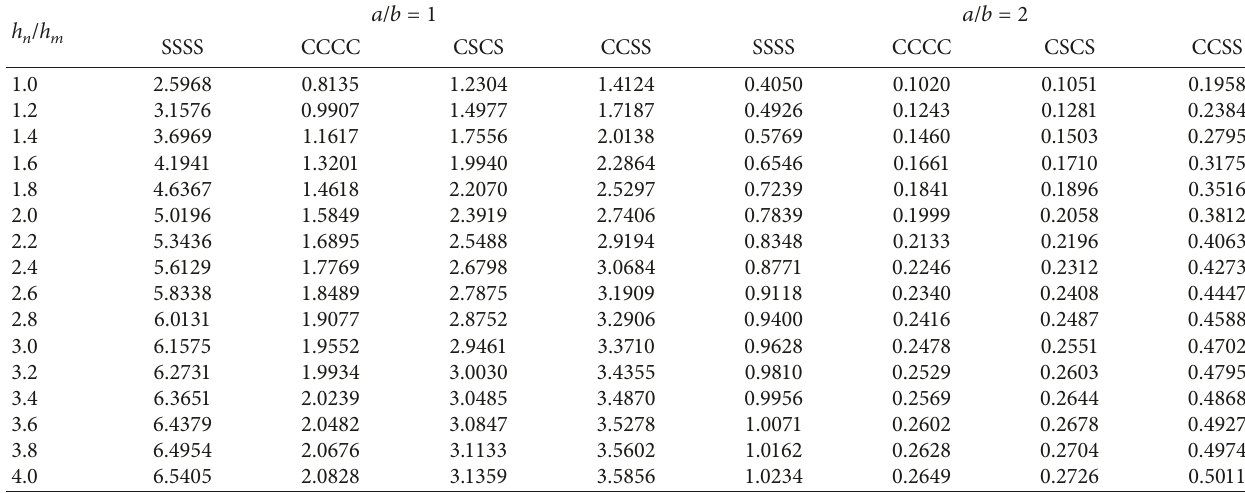
/h k /E � 1. n m with st b